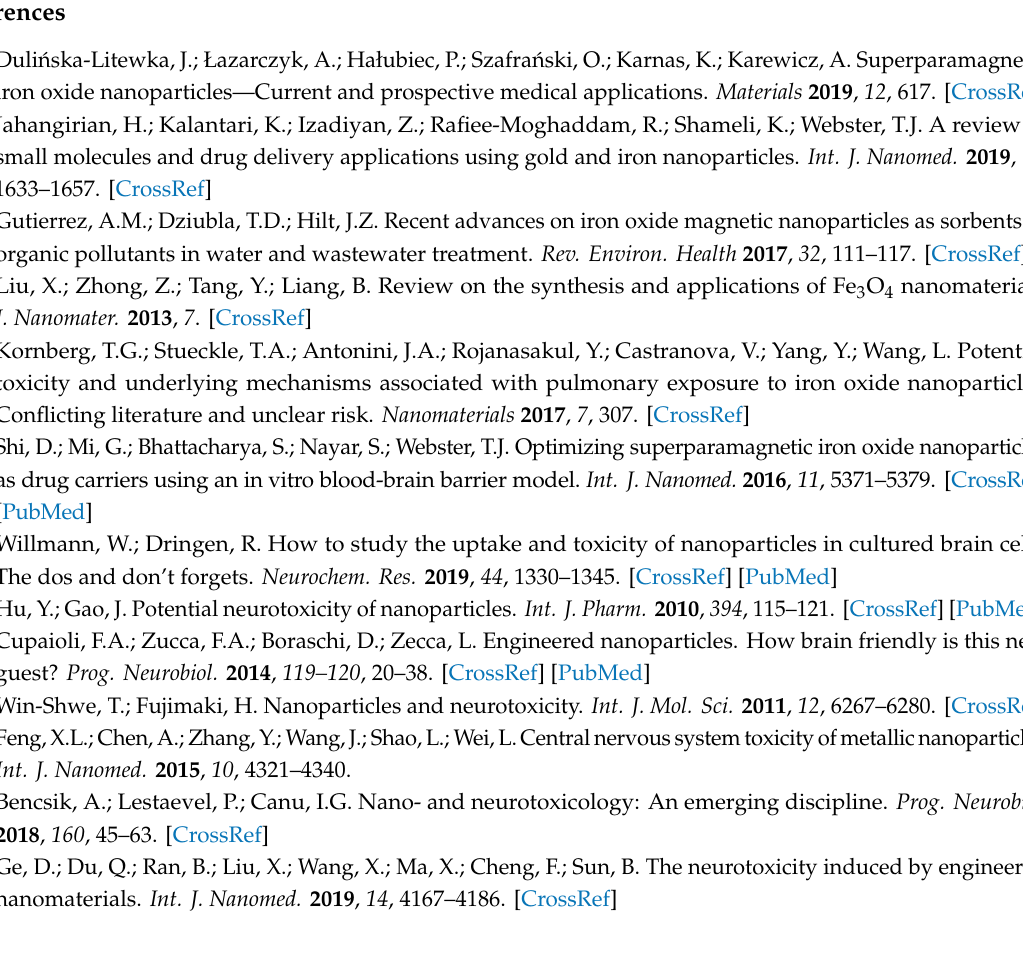
Figure S1: Optical properties of Fe 3 O 4